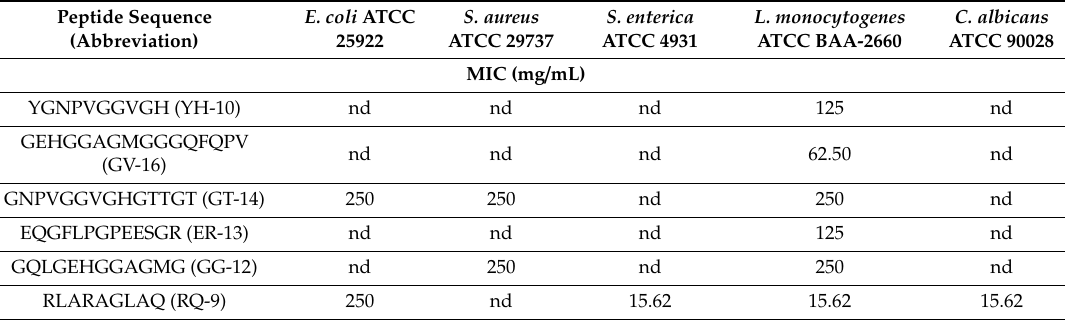
Figure 3. Viability (in %) C. albicans ATCC 90028 ( A , samples GT-14, GG-12 and RQ-9) and S. enteritidis ATCC 4931 ( B , sample RQ-9) in the presence of synthetic peptides samples, *** p < 0.001 versus the other samples, ### p < 0.05 versus the control cultures of yeast or bacteria. Table 6. Minimum inhibitory concentration (MIC) of tested